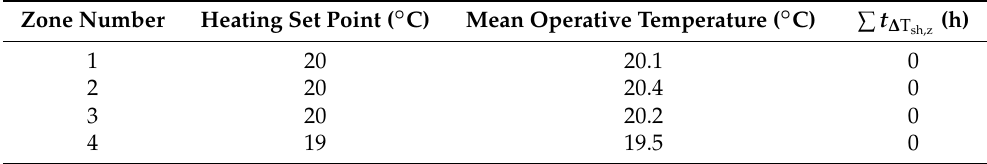
Table 6. Heating set point and mean operative temperature with corresponding undershoot time of the simulated heated